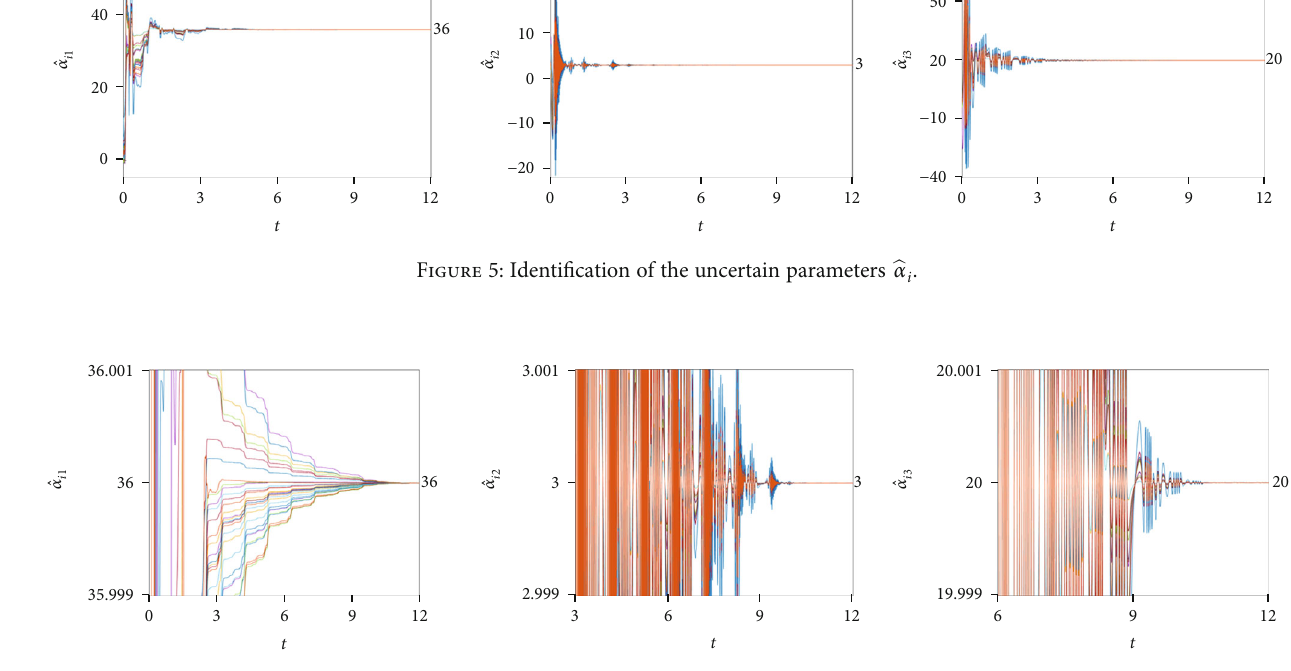
Figure 6: Partial ampli fi cation of the uncertain parameters b α